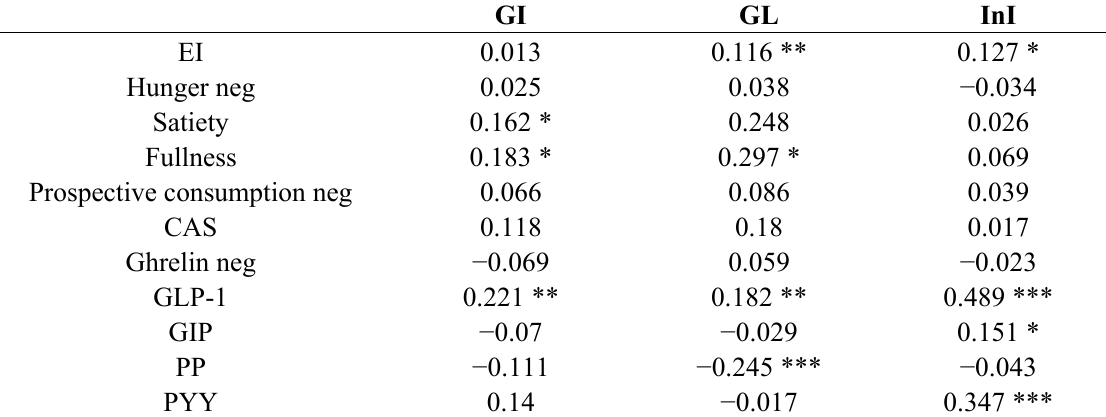
Figure 2. Plasma gastrointestinal hormones concentrations. ( a ) grhelin; ( b ) GLP-1; ( c ) GIP; ( d ) PP; values are expressed as the mean ± SEM ( n = 20). GIP, gastric inhibitory polypeptide; GLP-1, glucagon-like peptide-1; LMM, linear mixed-effects model; PP, pancreatic polypeptide; SEM, standard error of the mean. Table 4. Values of standardized coefficients of association for global relations between GI, GL and InI and ad libitum energy intake, appetite scores and gastrointestinal hormones AUCs after consuming the breads from all data obtained by